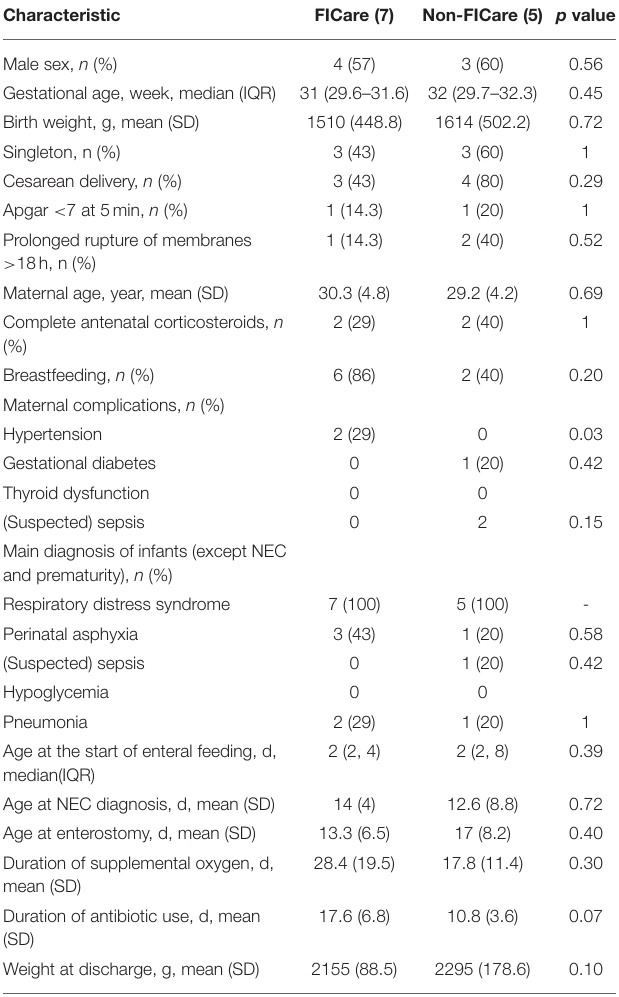
TABLE 1 | Baseline data: Infant demographics and maternal characteristics. Characteristic FICare (7)